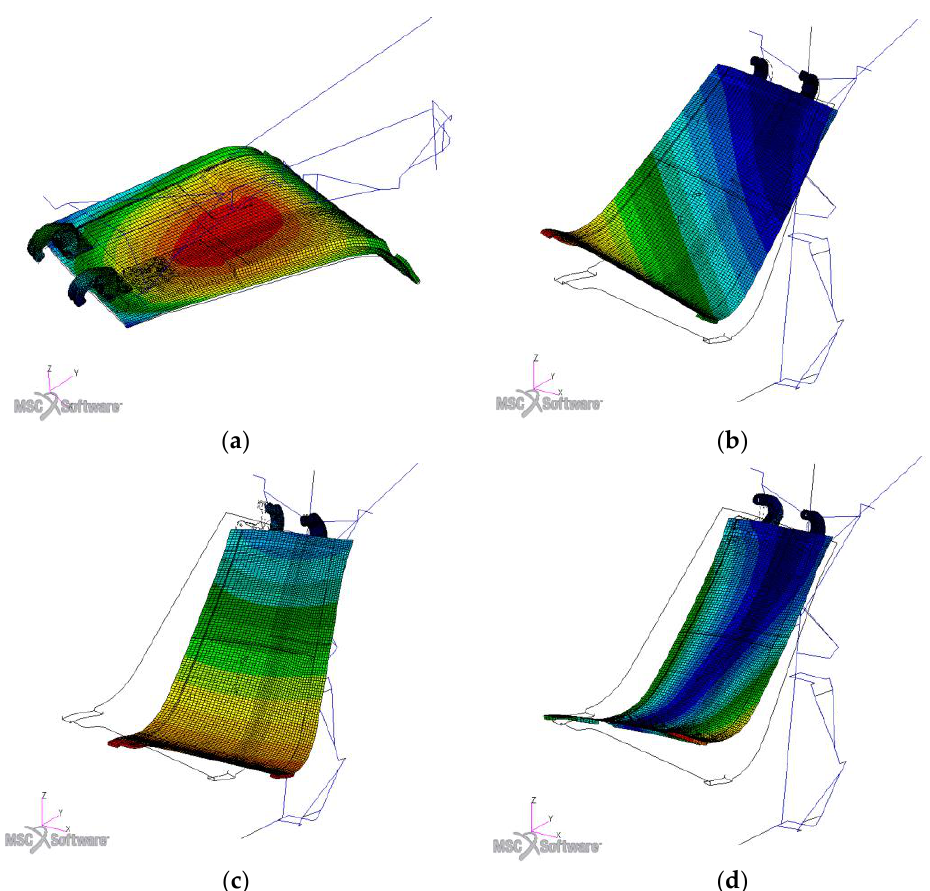
Figure 10. Normal modes of an MLG door baseline configuration: closed door ( a ) main flexural mode f = 200 Hz; open door ( b ) harmonic mode, f = 20.6 Hz; ( c ) fore and aft mode, f = 36 Hz; and ( d ) torsional mode, f = 52.4 Hz.